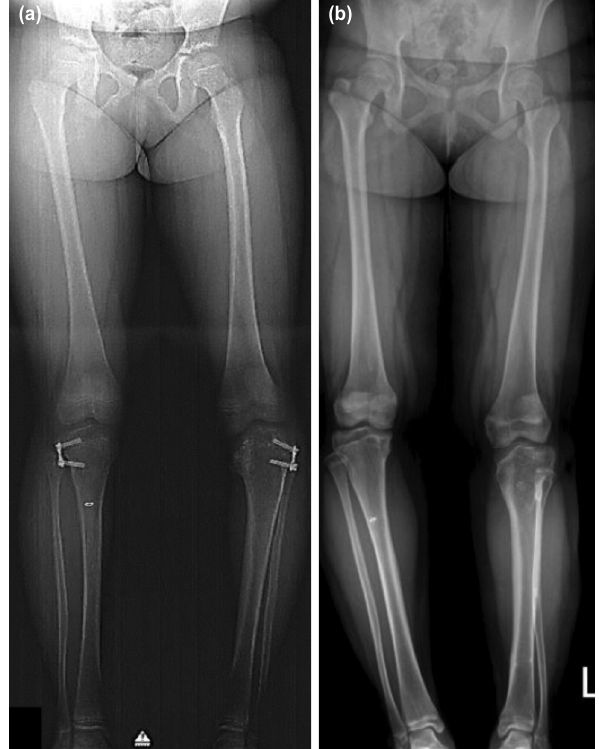
Anteroposterior view scanogram of a 6-year old girl with Fig. 5: bilateral tibia vara and a BMI of 26. She was treated with 8-plates (Case 13). (a) Post-operative radiograph showing successful correction of the right tibia, but minimal improvement of the left tibia after 21 months. (b) Rebound deformity to MAD zone 3 on the right tibia five years after implant removal. Corrective osteotomy had been performed on the left tibia.